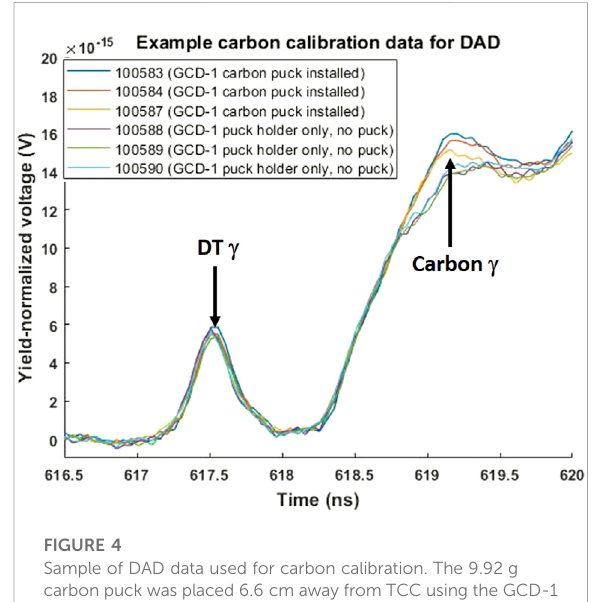
FIGURE 4 Sample of DAD data used for carbon calibration. The 9.92 g carbon puck was placed 6.6 cm away from TCC using the GCD-1 carbon puck holder. Carbon gammas from this puck were detected by DAD at an average scattering angle of 143 ° . Data was collected with and without the carbon puck in position. Background data without the carbon puck included the presence of the aluminum puck holder. All signals shown here are normalized to the relevant DT neutron